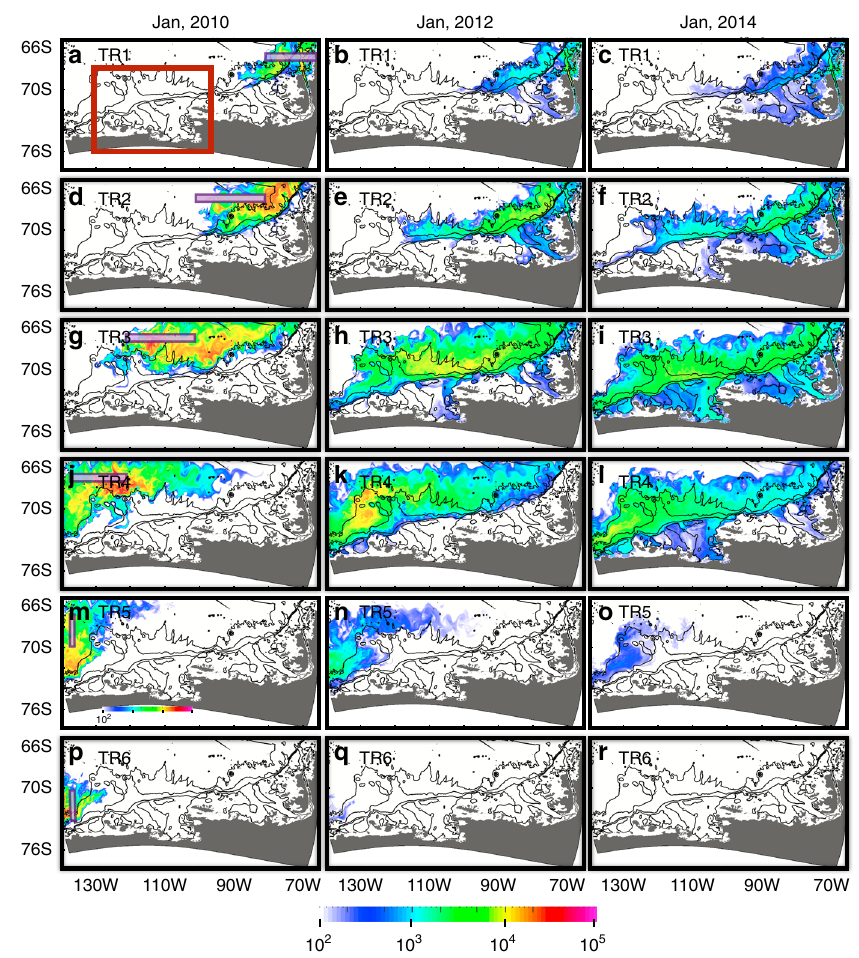
Fig. 4 Monthly mean spatial distributions of vertically integrated tracers (TR) representing CDW after 1 (Jan 2010), 3 (Jan 2012), and 5 (Jan 2014) years of model simulation. a – c TR1, d – f TR2, g – i TR3, j – l TR4, m – o TR5, and p – r TR6 are used to investigate the CDW pathways from different locations and initial locations of these tracers are shown by the purple boxes in the left panels. Close up of the region enclosed by the red rectangle ( a ) is shown in Fig. 5. For all panels, bathymetric contours of 500, 1500, 3000, and 4000 m are shown with thin black